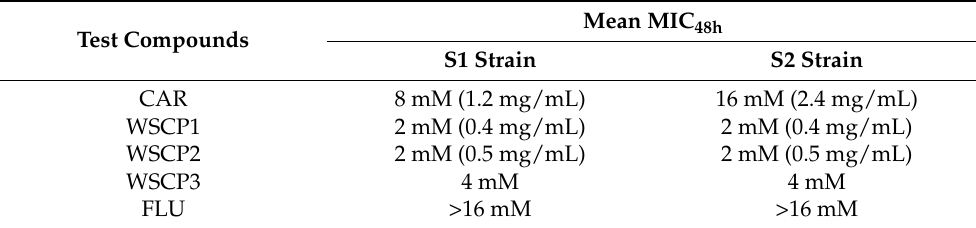
Table 2. MIC values for the CAR and its prodrugs and the FLU in the S1 and the S2 strains of C. albicans 1